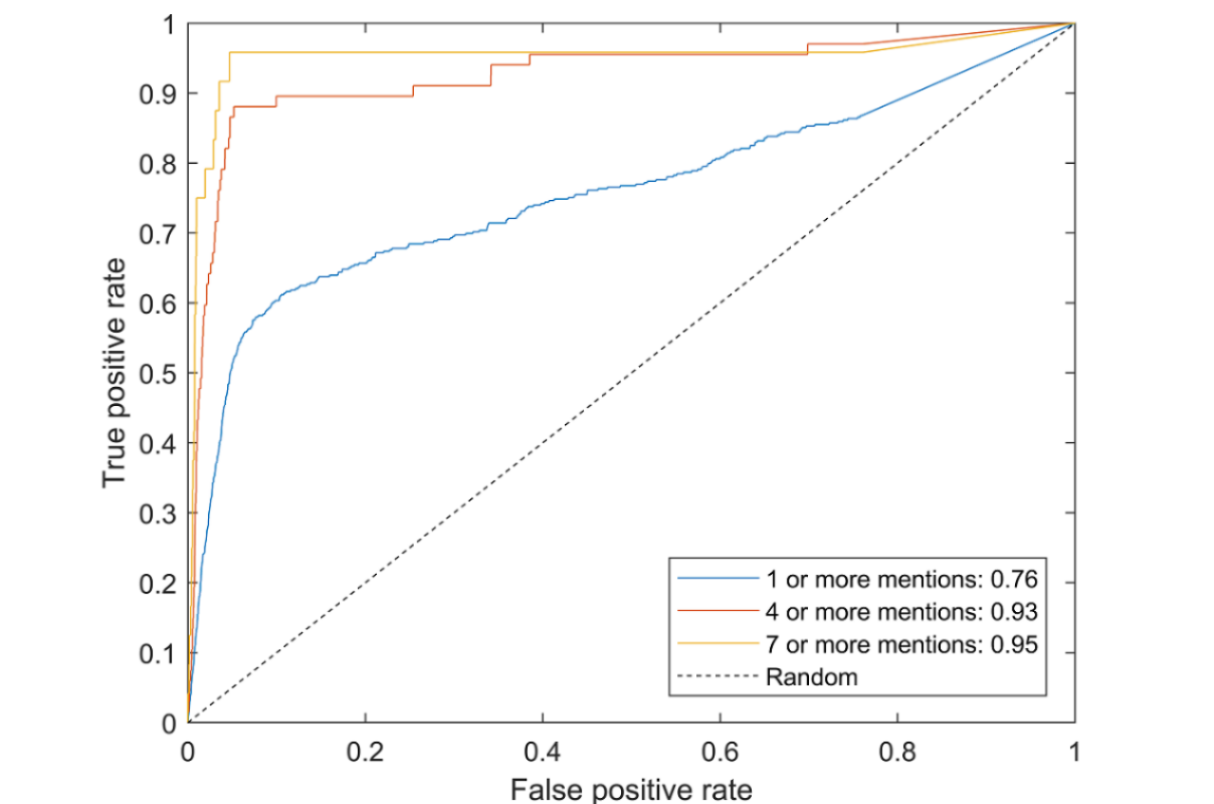
Figure 3. Receiver operating characteristic curve for the prospective cohort; the area under the curve (AUC) values for the different settings are presented in the